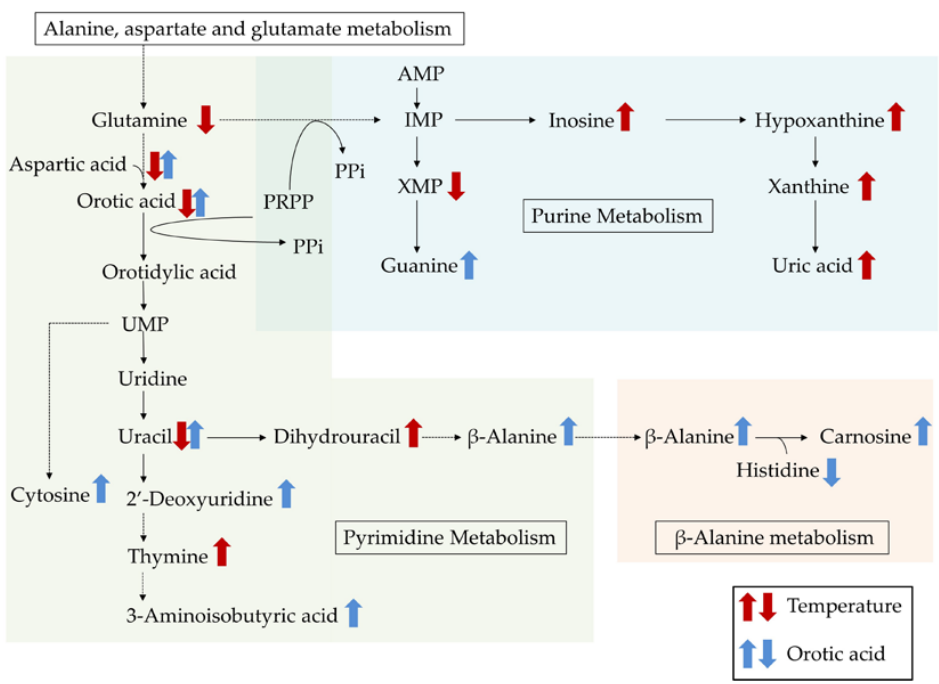
Figure 2. Integrated overview of the metabolic changes induced by either a cyclic high ambient temperature or by feeding orotic acid. Red arrows indicate high ambient temperature-induced changes in the metabolites, and blue arrows indicate orotic acid-induced changes. The metabolic scheme was based on information gathered from the KEGG PATHWAY Database (http: // www.genome.jp / kegg /